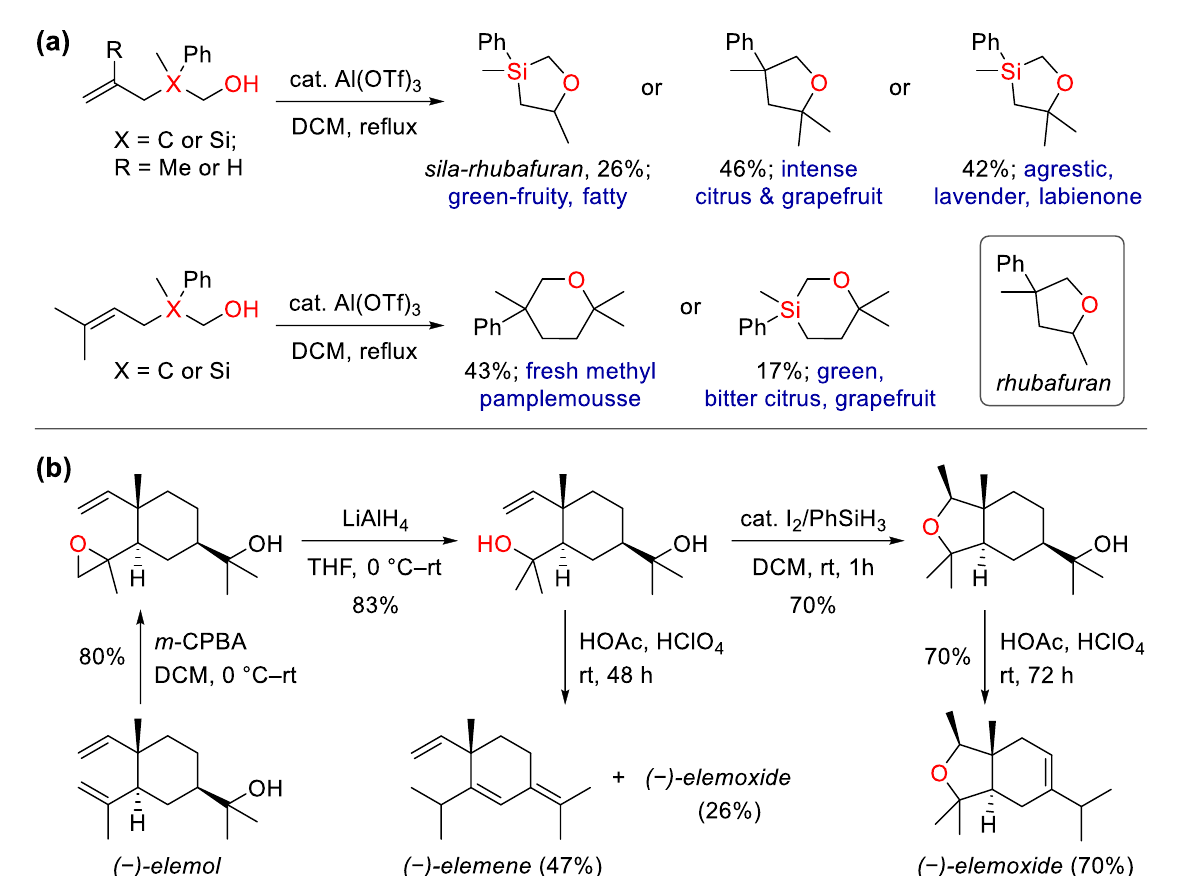
Scheme 11. Synthesis of heterocyclic fragrances via intramolecular hydroalkoxylation. ( a ) Synthesis of the silicon-containing and ring-expanded analogs of rhubafuran. ( b ) Synthesis of ( −